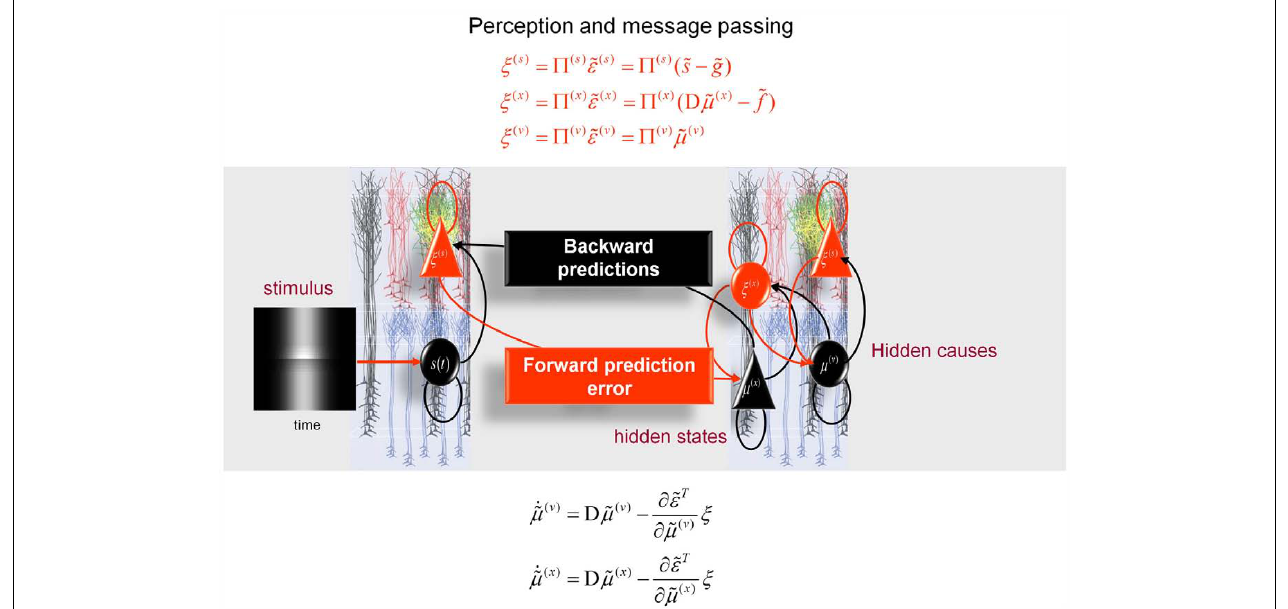
FIGURE 5 | Hierarchical message-passing in the brain. The schematic details a neuronal architecture that optimizes the conditional expectations of hidden variables in hierarchical models of sensory input of the sort illustrated in Figure 3 . It shows the putative cells of origin of forward driving connections that convey prediction error from a lower area to a higher area (red arrows) and non-linear backward connections (black arrows) that construct predictions (Mumford, 1992; Friston, 2008).These predictions try to explain away (inhibit) prediction error in lower levels. In this scheme, the sources of forward and backward connections are superficial and deep pyramidal cells (triangles) respectively, where state-units are black and error-units are red.The equations represent a generalized gradient descent on free-energy (see main text) using the generative model of the previous figure. If we assume that synaptic activity encodes the conditional expectation of states, then recognition can be formulated as a gradient descent on free-energy. Under Gaussian assumptions, these recognition dynamics can be expressed compactly in terms of precision weighted prediction errors: ξ ( i ) : i = s , x , v on the sensory input, motion of hidden